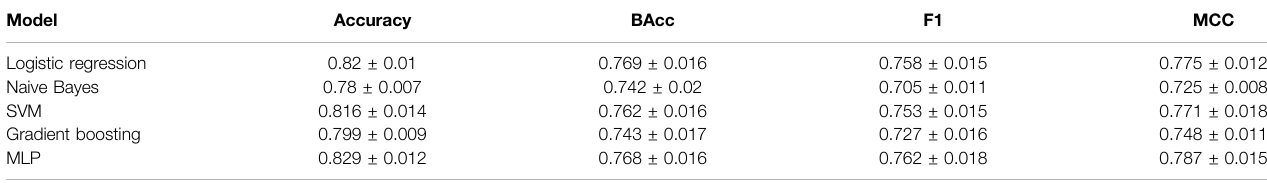
TABLE 2 | Results for the classi fi cation of taxonomic types on principal components. For each metric, the fi rst column is the average over the results 10 runs of the cross- validation, while the second column is the standard deviation of these results. Model